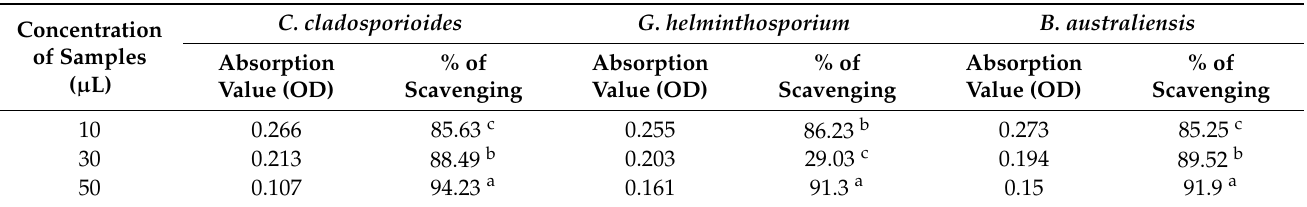
Table 7. H 2 O 2 antioxidant scavenging activity of the intracellular methanolic extract of Cladosporium cladosporioides, Graminicolous helminthosporium , and Bipolaris australiensis. Data are represented as means ± SD of three replicates. Numbers within a column followed by the same letters are not significantly different according to Duncan’s multiple range test at p ≤